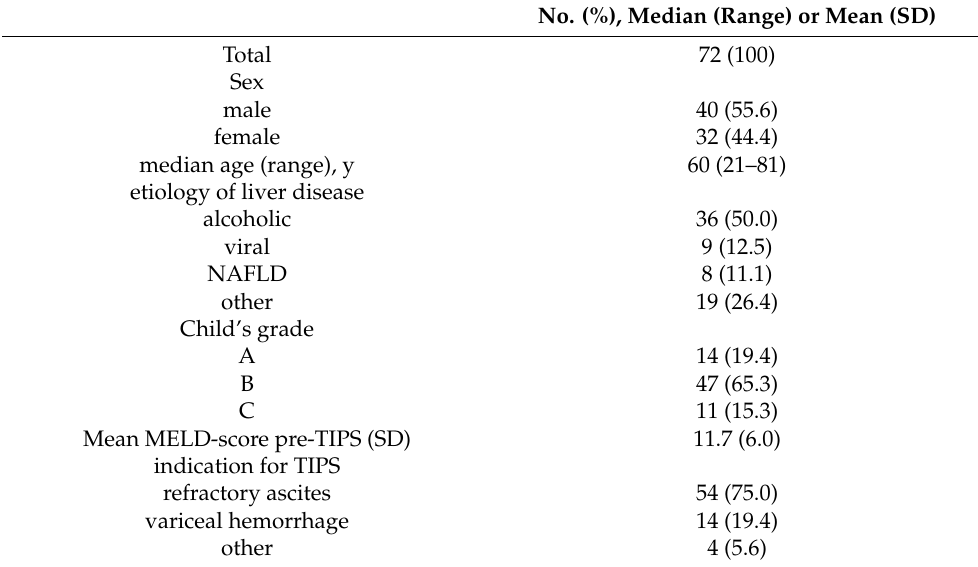
Table 1. Patient characteristics.